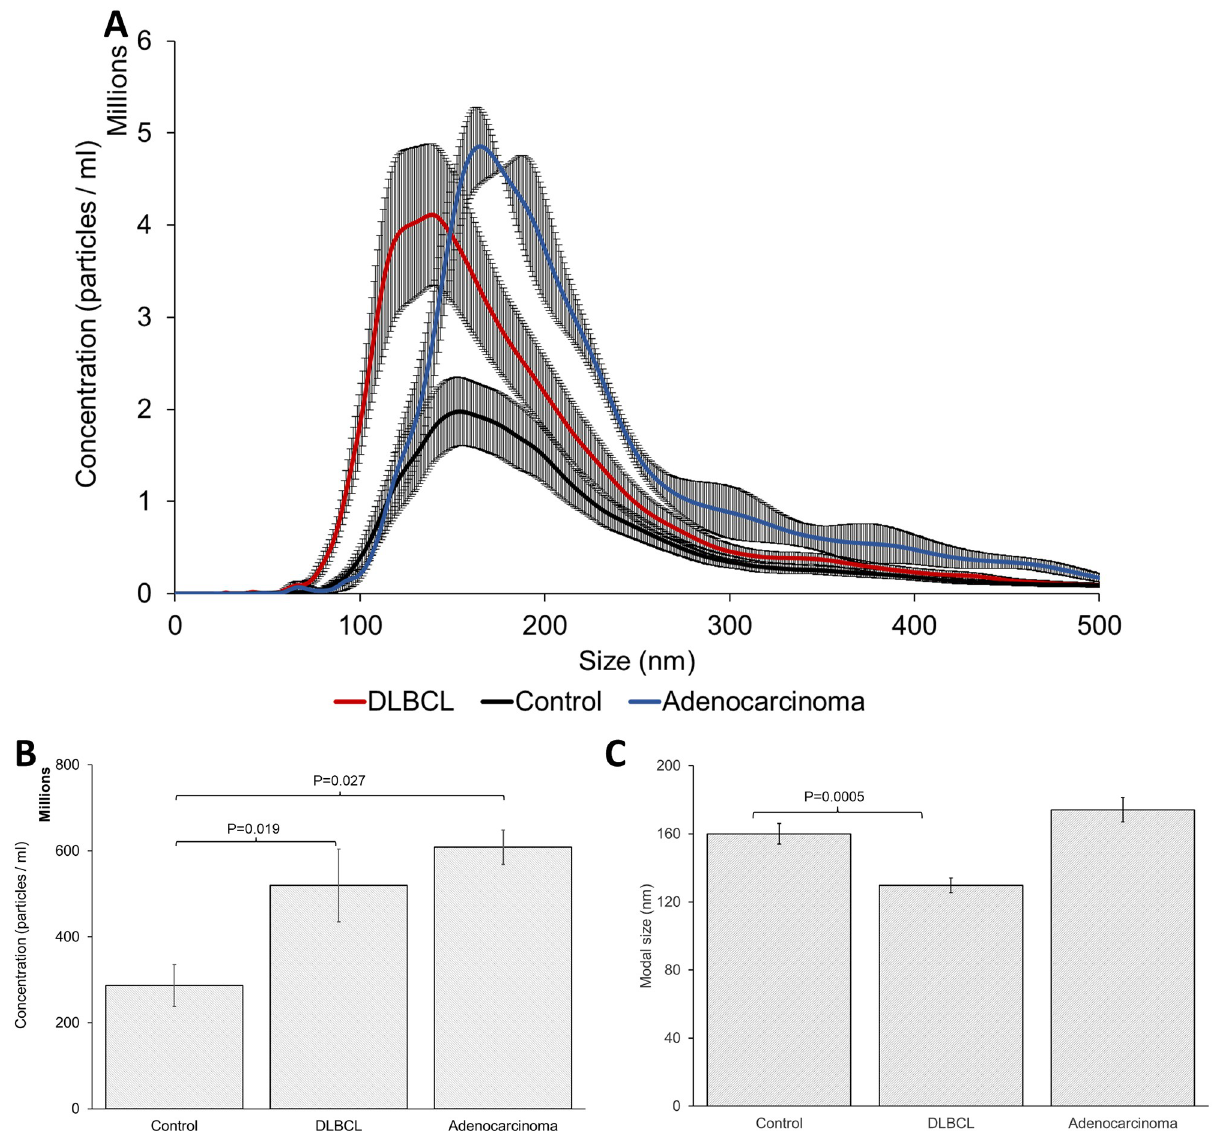
Fig 1. NanoSight analysis of particle size distribution of EVs isolated from canine plasma. (A) Line graph of healthy control, DLBCL and adenocarcinoma patient particle size distribution. (B) Bar graph of total EV concentration of particles / ml and (C) modal size of healthy control, DLBCL and adenocarcinoma patient EV